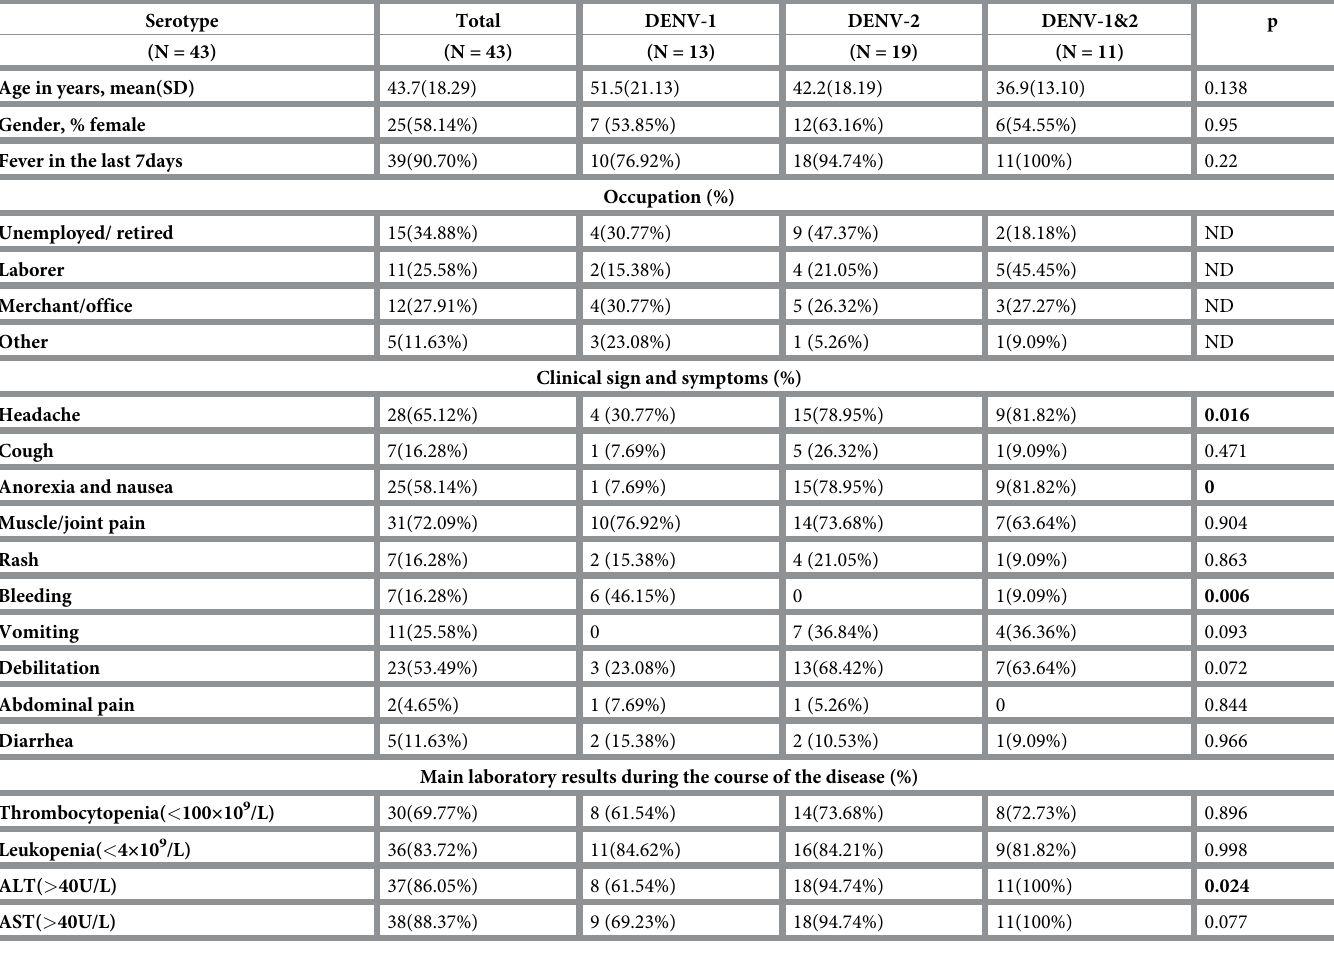
Table 1. Clinical and laboratory outcome measures for patients with DENV-1, DENV-2 vs DENV-1 mixed with DENV-2